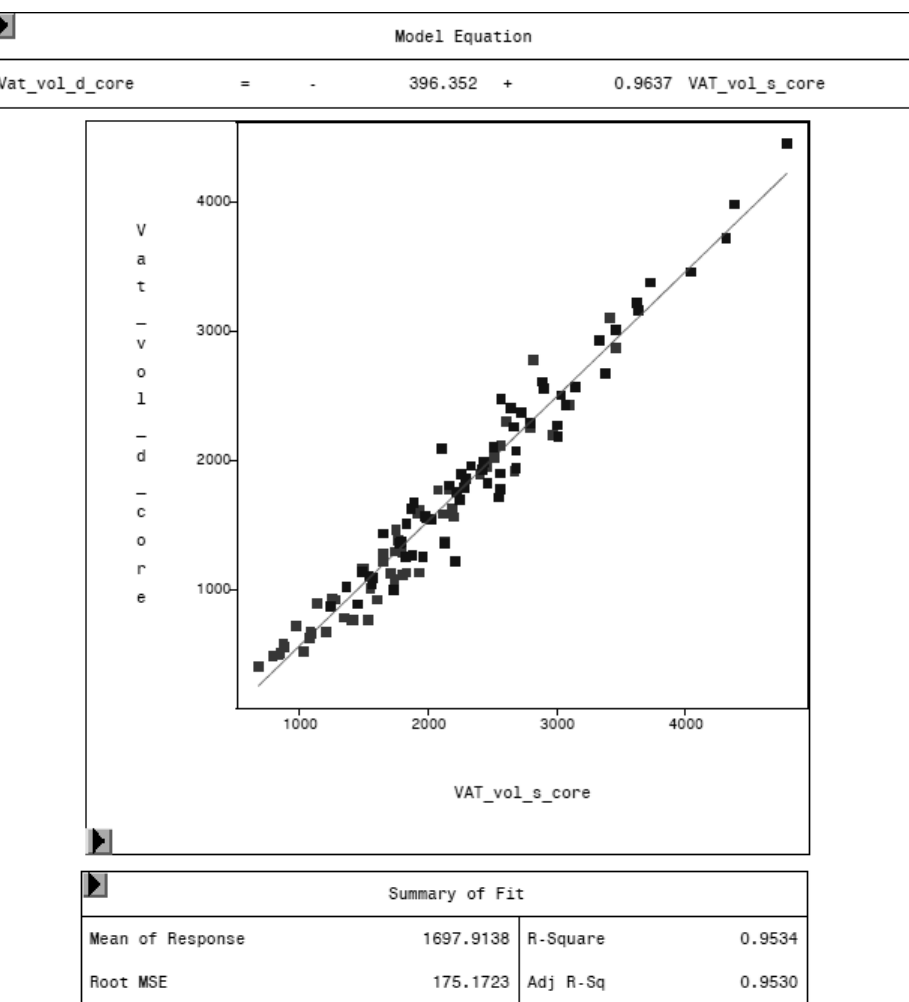
Figure 6. Relationship between VAT volume in “thick” mode (VAT_vol_d_core, in cm 3 ) and VAT volume in “standard” mode (VAT_vol_s_core, in cm 3 ) measured by DXA. “Standard” mode yields higher values of VAT volume, as the model equation represents. Table 3. Arithmetic means and standard deviations of VAT volume measured by DXA for “thick” and “standard” modes, and by MRI.